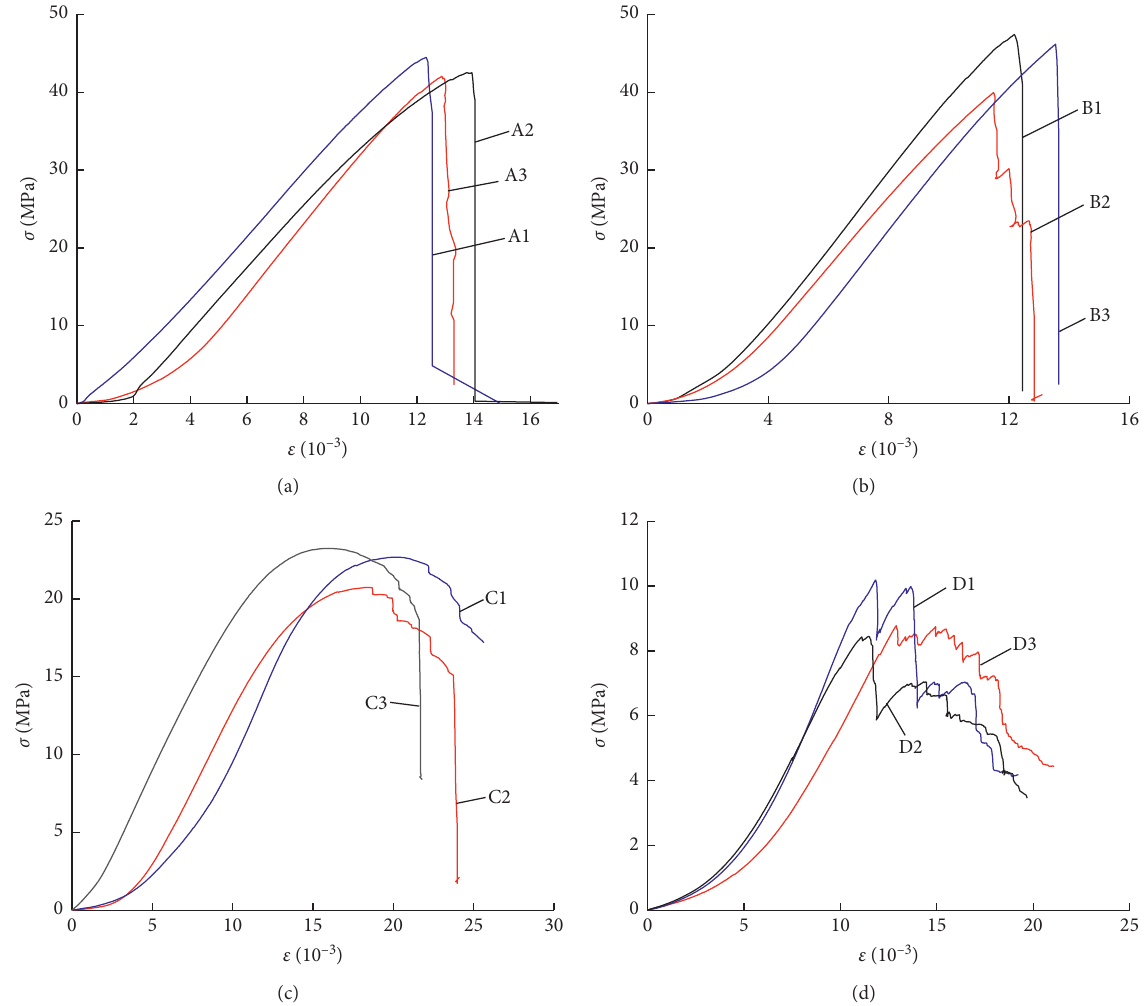
Figure 6: Stress-strain curve of each group of samples during uniaxial compression test. (a) Natural. (b) Dehydration at 45 ° C. (c) Water saturation. (d) High-temperature dehydration at 220 ° C.